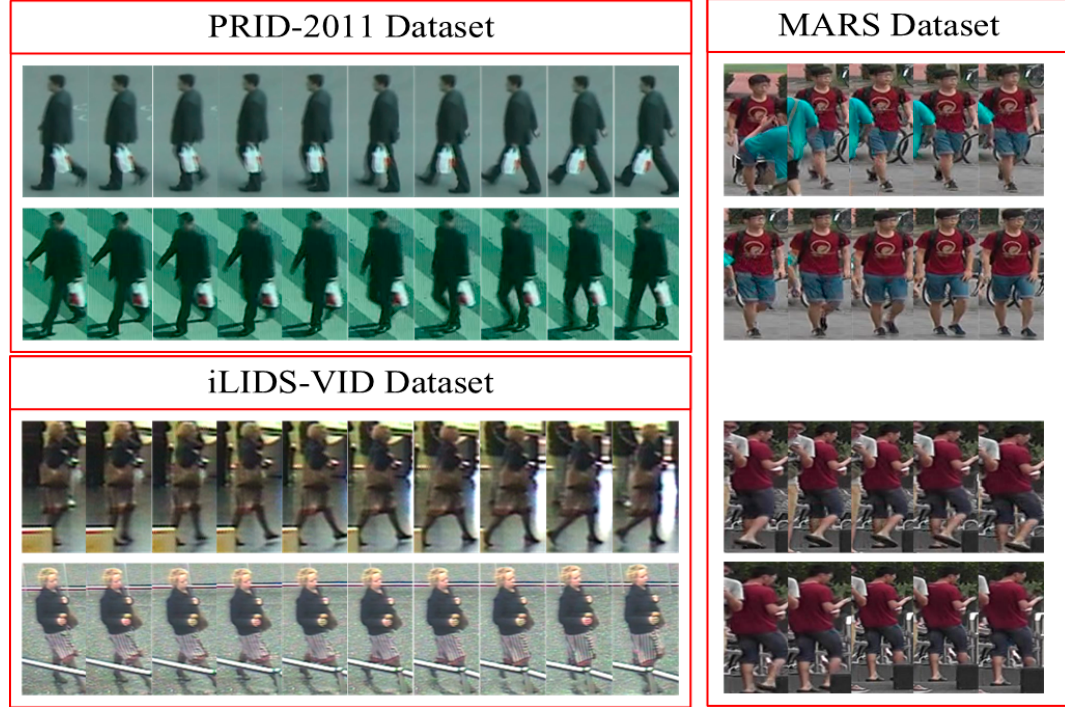
Figure 7. Some samples of persons from different camera-views in three public datasets, including the PRID-2011 dataset, the iLIDS-VID dataset and the Motion Analysis and Re-identification Set(MARS)